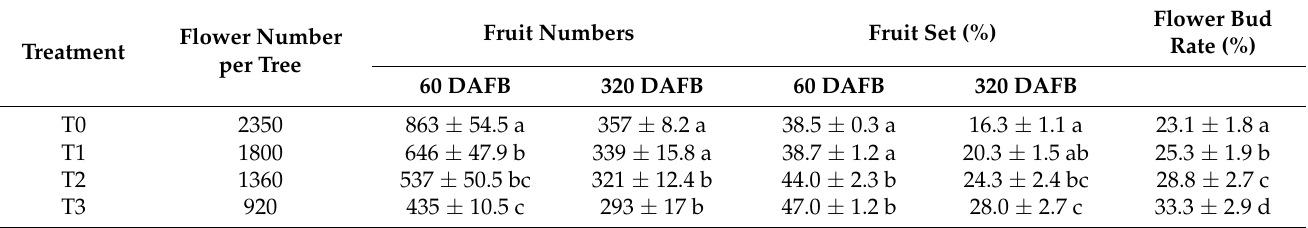
Table 1. Effect of flower numbers per tree on fruit set and flower bud differentiation rate in the following year of C. oleifera . Values shown are means ± S.E. ( n =